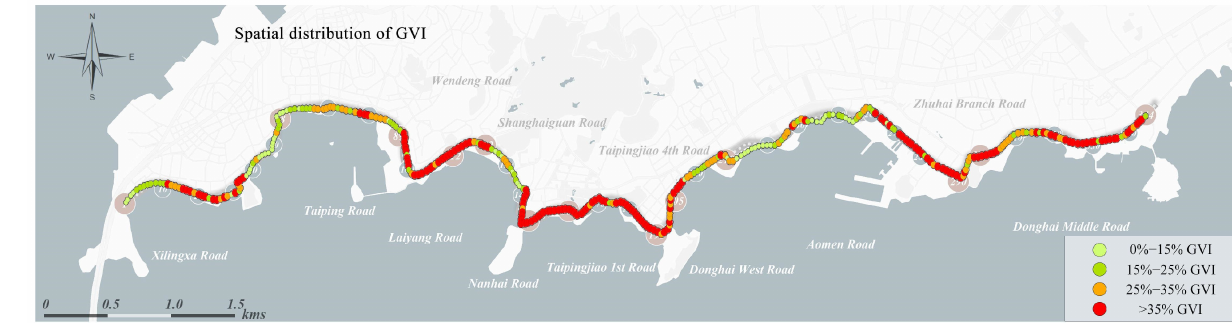
Figure 7. Spatial distribution of GVI.